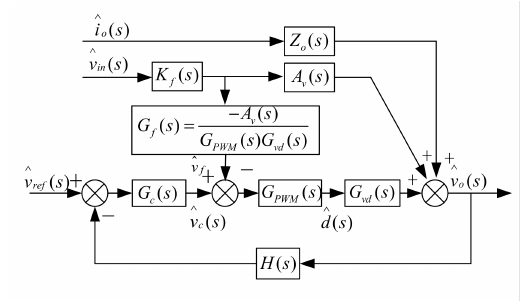
Figure 9. The small-signal IVFF control block